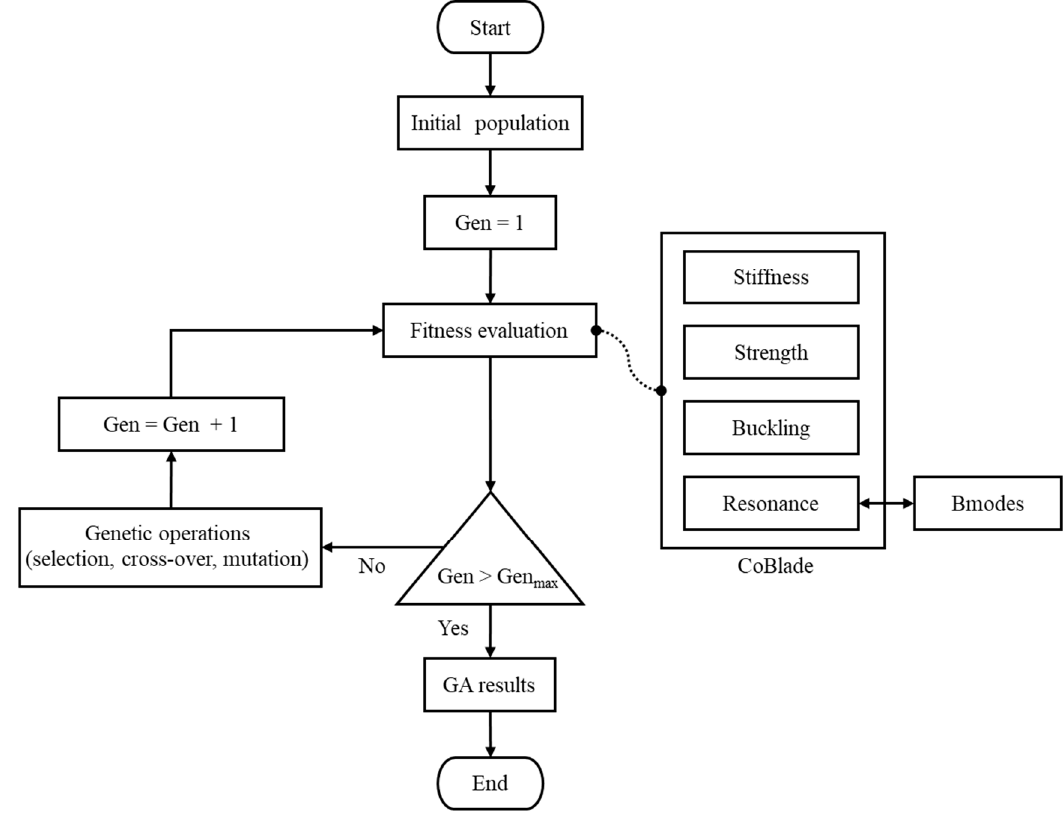
Figure 4. Flowchart for genetic algorithm (GA) optimization method. next generation by applying the principles of natural selection, cross-over and